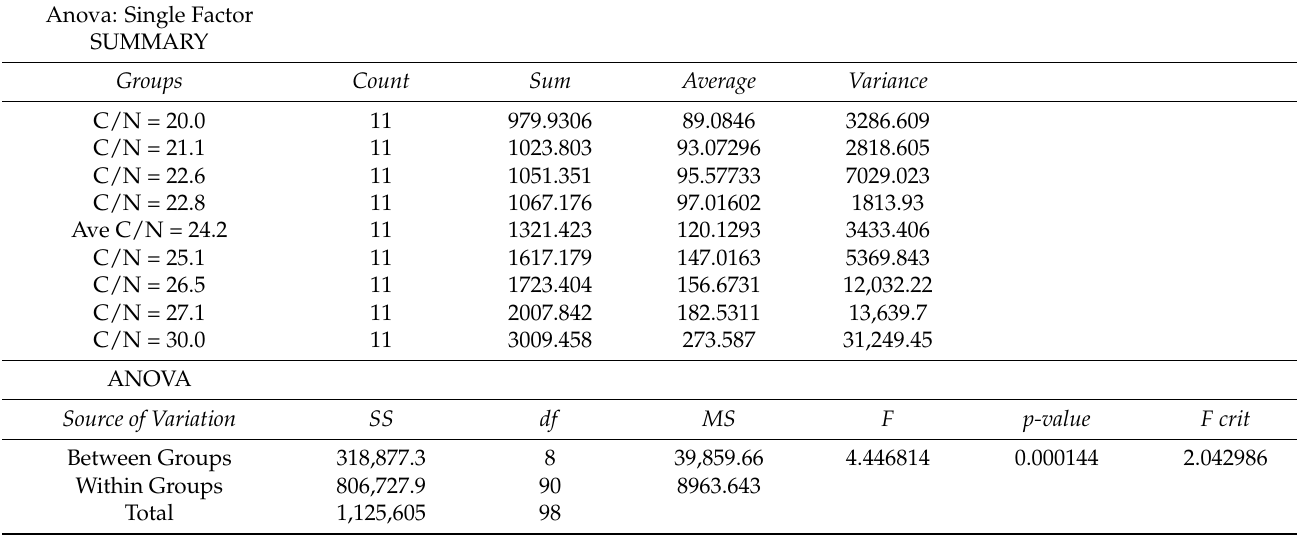
Table A8. One-way (ANOVA) test for methane yield every three days from all reactors. Anova: Single Factor